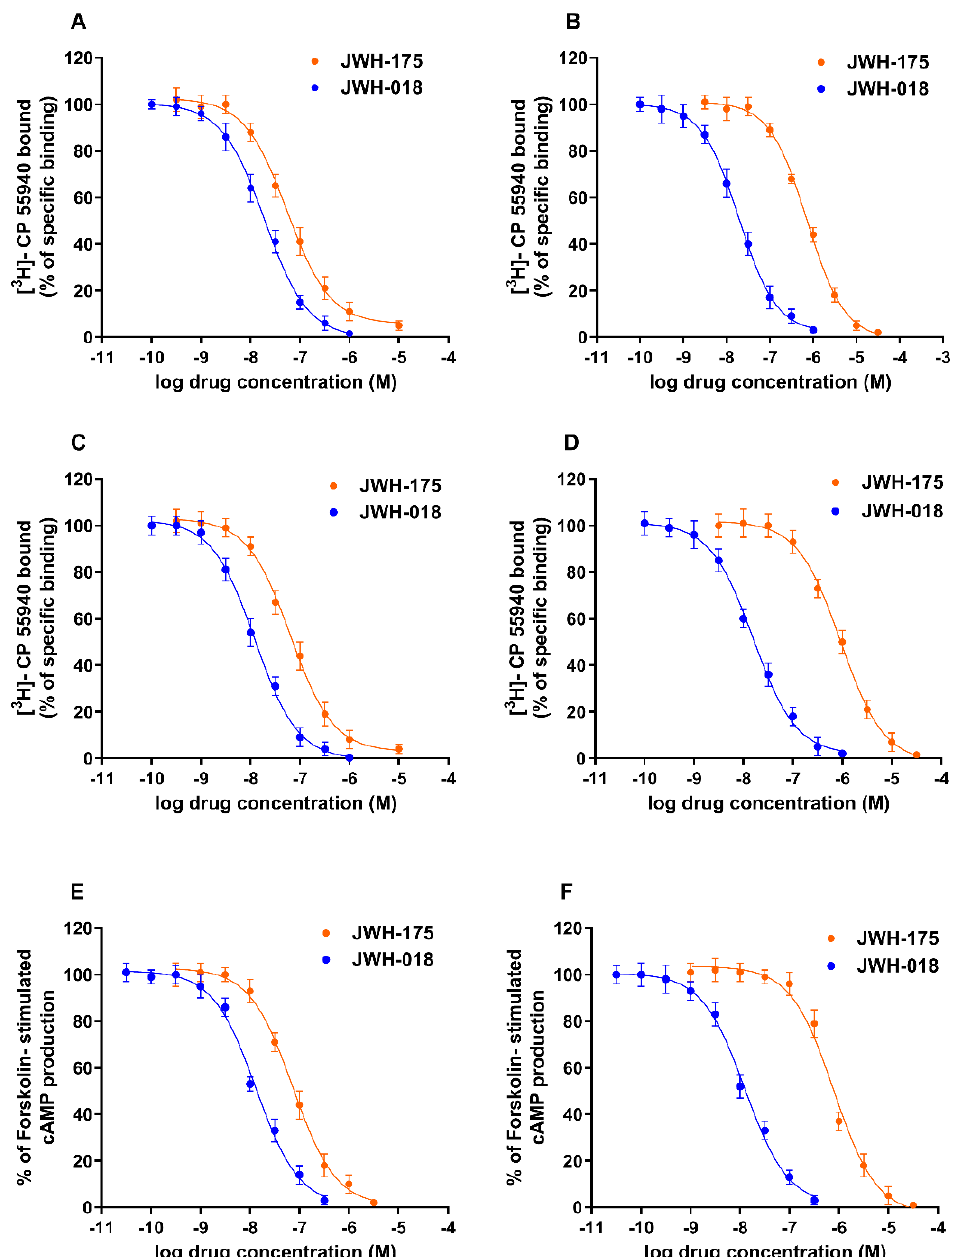
Figure 2. Competition curves of specific [3H]-CP 55,940 binding by synthetic cannabinoids JWH-175 and JWH-018 in CHO cell membranes transfected with human CB1 receptors ( A ) or human CB2 receptors ( B ) and to CB1 receptors expressed in mouse brain membranes ( C ) or CB2 receptors expressed in mouse spleen membranes ( D ). Inhibition curves of forskolin-stimulated cAMP accumulation by JWH-175 and JWH-018 in CHO cells transfected with human CB1 receptors ( E ) or human CB2 receptors ( F ). Results are given as the mean ± SEM of three independent experiments performed in duplicate. Cyclic AMP experiments were performed to evaluate the potency of the examined compounds in CHO cells transfected with human CB1 or CB2 receptors. JWH-175 was 5.38 times less potent at the human CB1 receptors than the reference compound JWH-018 (Table 1). In line with binding experiments, JWH-175 showed a higher potency for CB1 than CB2 receptors. All the tested compounds were able to completely inhibit the forskolin-stimulated cAMP production, thus behaving as full